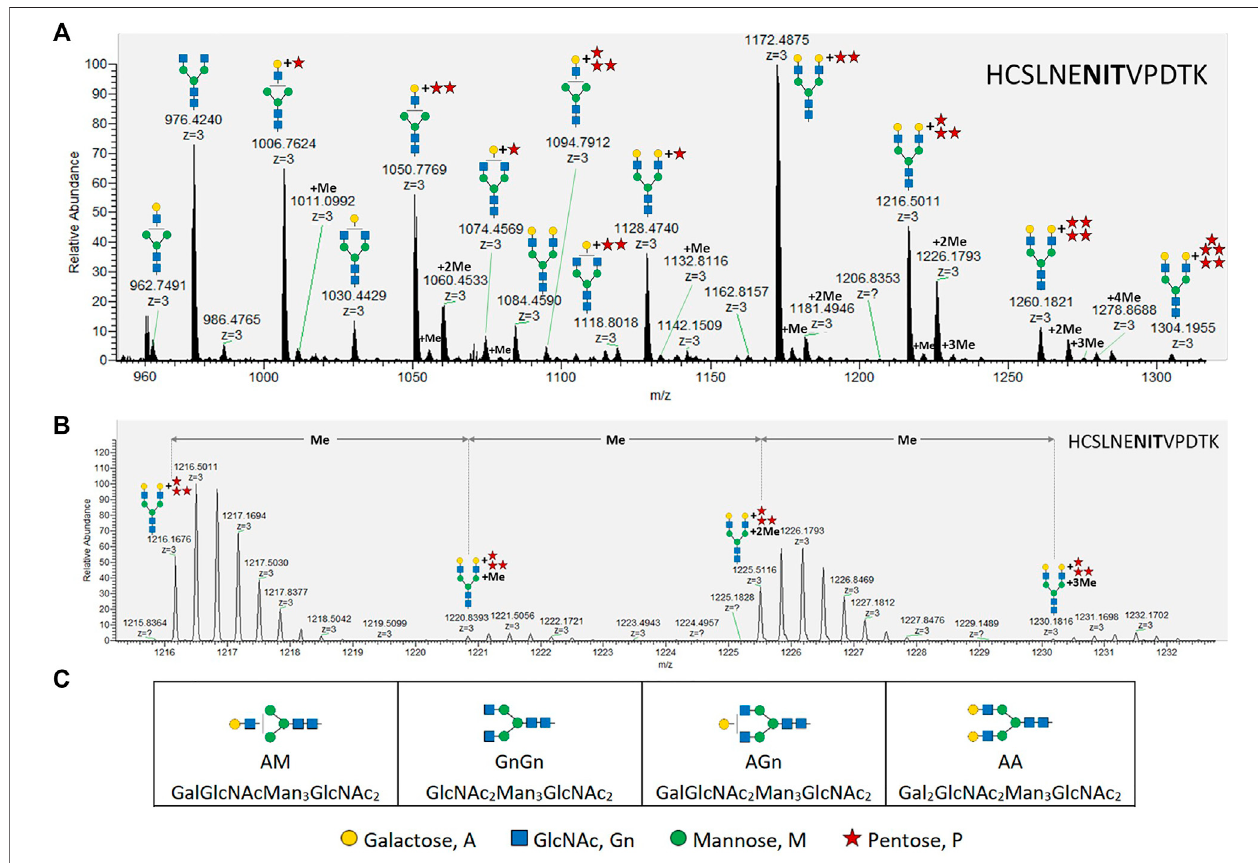
FIGURE 1 | MS analysis of X24-derived rhEPO glycopeptide HCSLNENITVPDTK. (A) Precursor mass range (27.6 – 28.7 min) displaying the X24-derived triple charged ([M+3H + ] + ) glycopeptide HCSLNE NIT VPDTK with different N -glycans attached. (B) An average mass shift of 14.0157 Da between the calculated single charged ([M+1H + ] + ) precursor masses (from left to right: 1216.1676 ([M+3H + ] + ) → 3646.4882 ([M+1H + ] + ); 1220.8393 ([M+3H + ] + ) → 3660.5033 ([M+1H + ] + ); 1225.5116 ([M+3H + ] + ) → 3674.5202 ([M+1H + ] + ); 1230.1816 ([M+3H + ] + ) → 3688.5302 ([M+1H + ] + )) indicates the addition of methyl groups. Me: methyl, monoisotopic mass shift: +14.0157 Da. (C) Abbreviations and corresponding cartoons for non-pentosylated glycan structures described in this work. N -glycans are depicted according to the glycan nomenclature of the Consortium for Functional Glycomics (http://www.functionalglycomics.org), while the attachment of an unknown pentose is depicted as a red